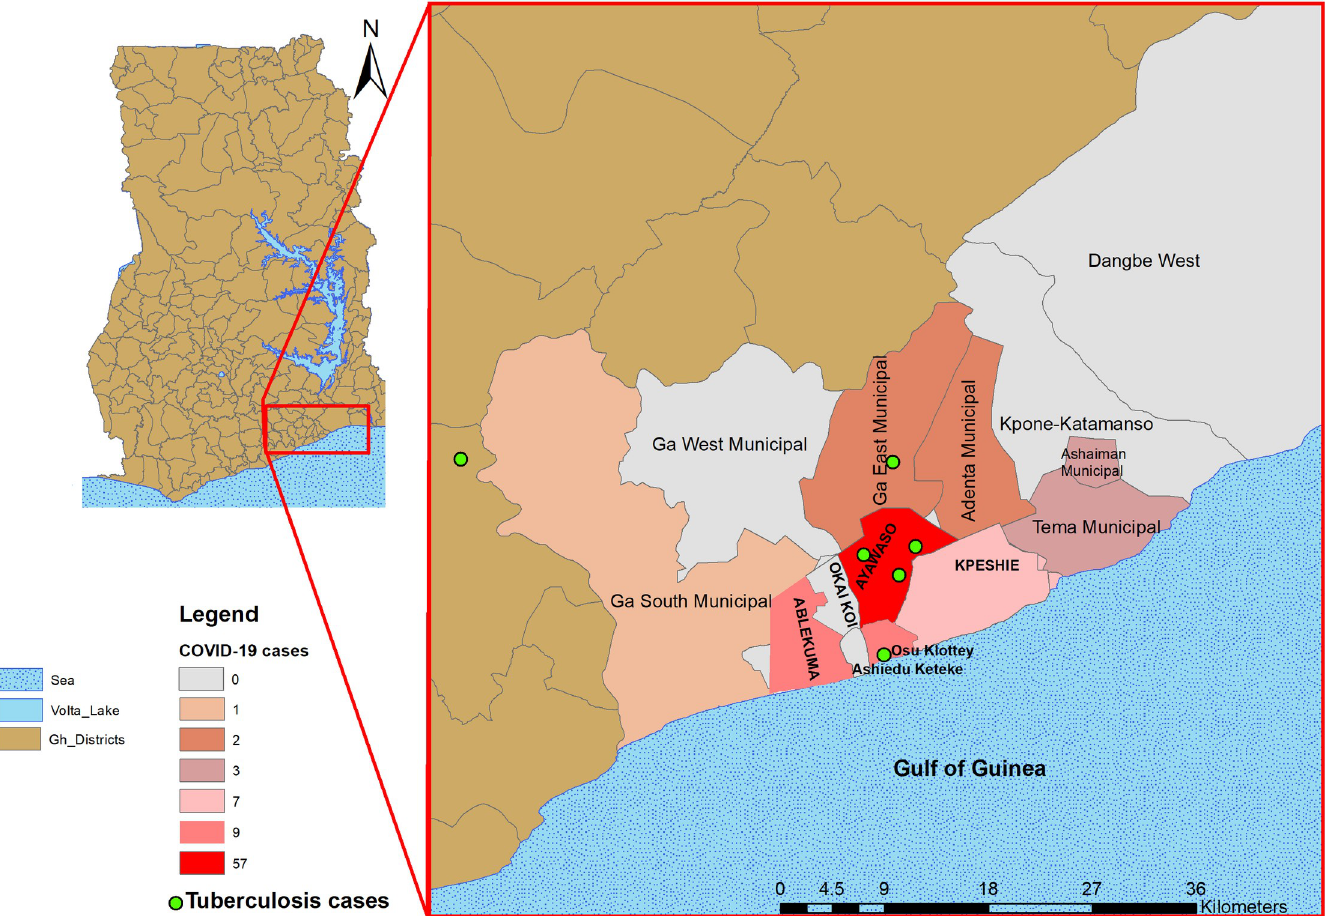
Fig 1. Geographical density of COVID-19 and distribution of TB cases within the sampling period.